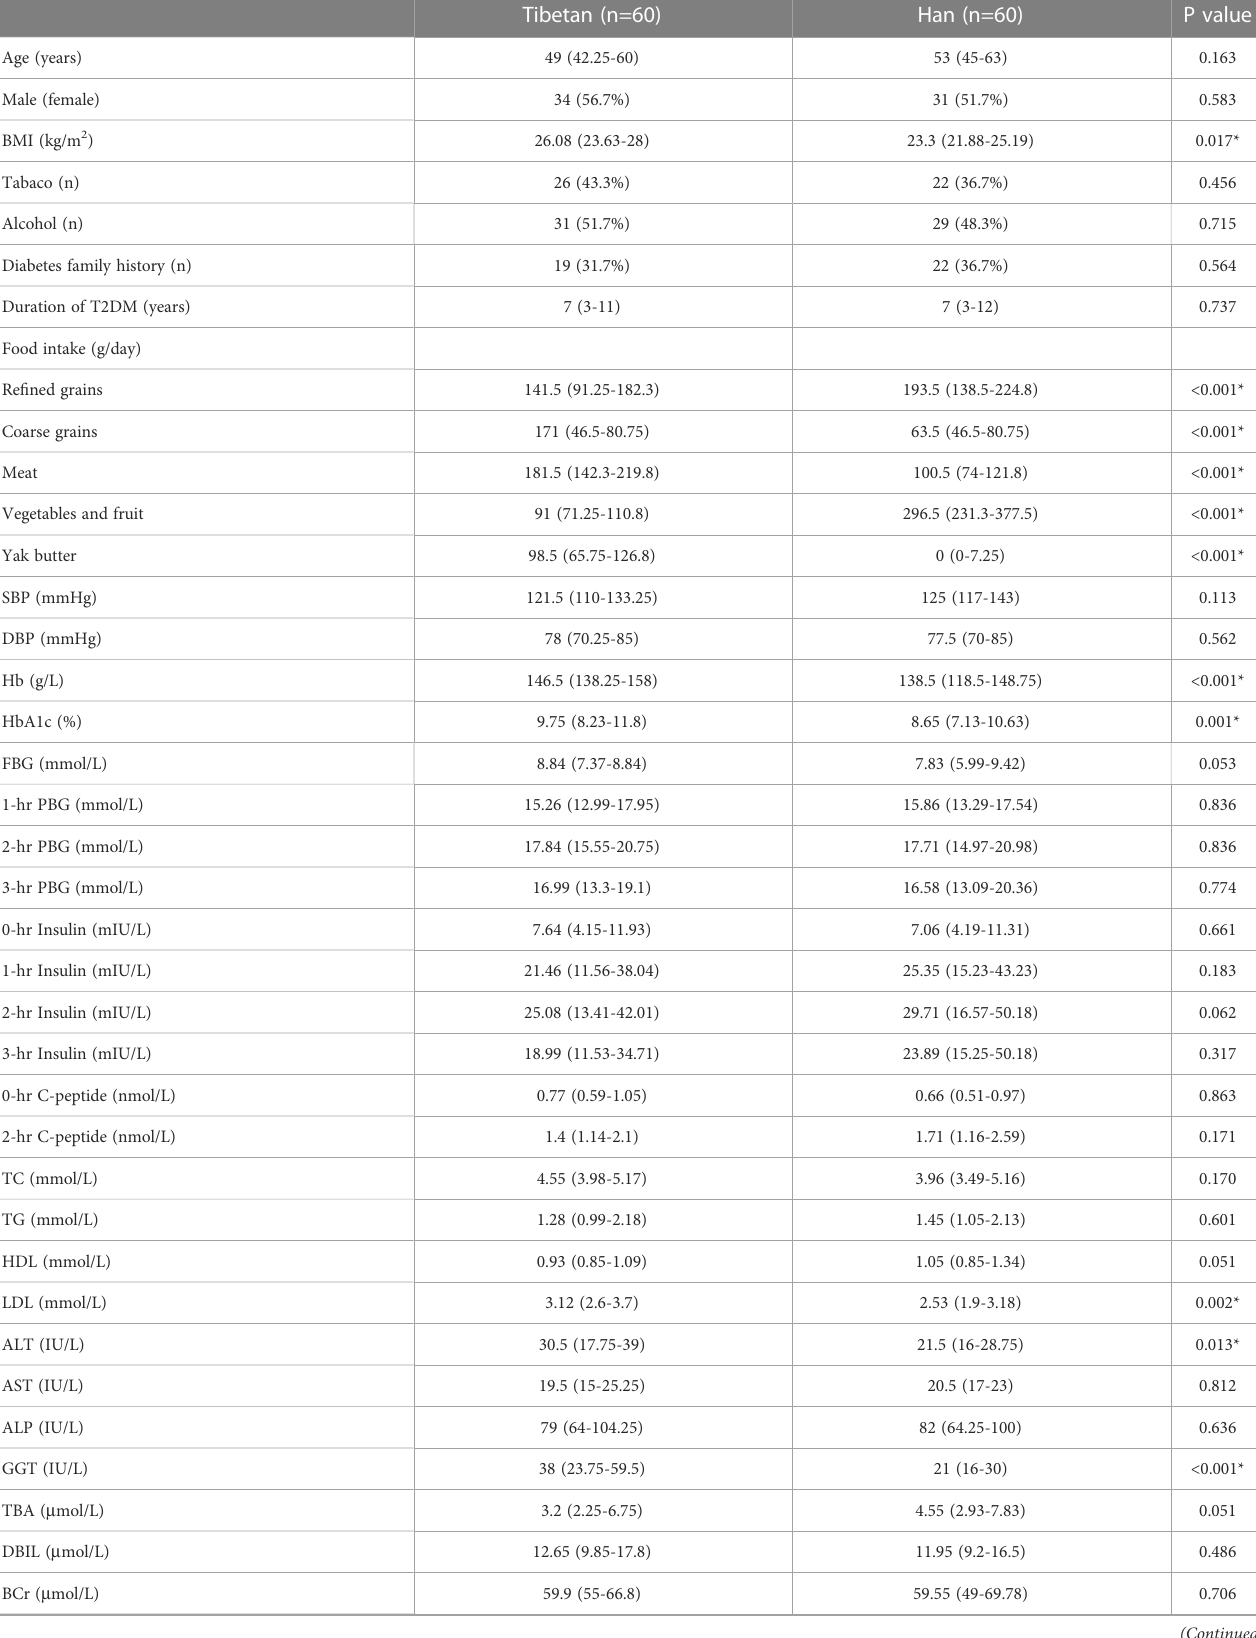
TABLE 1 Demographical and biochemical characteristics between Tibetan and Han T2DM patients in cross-sectional